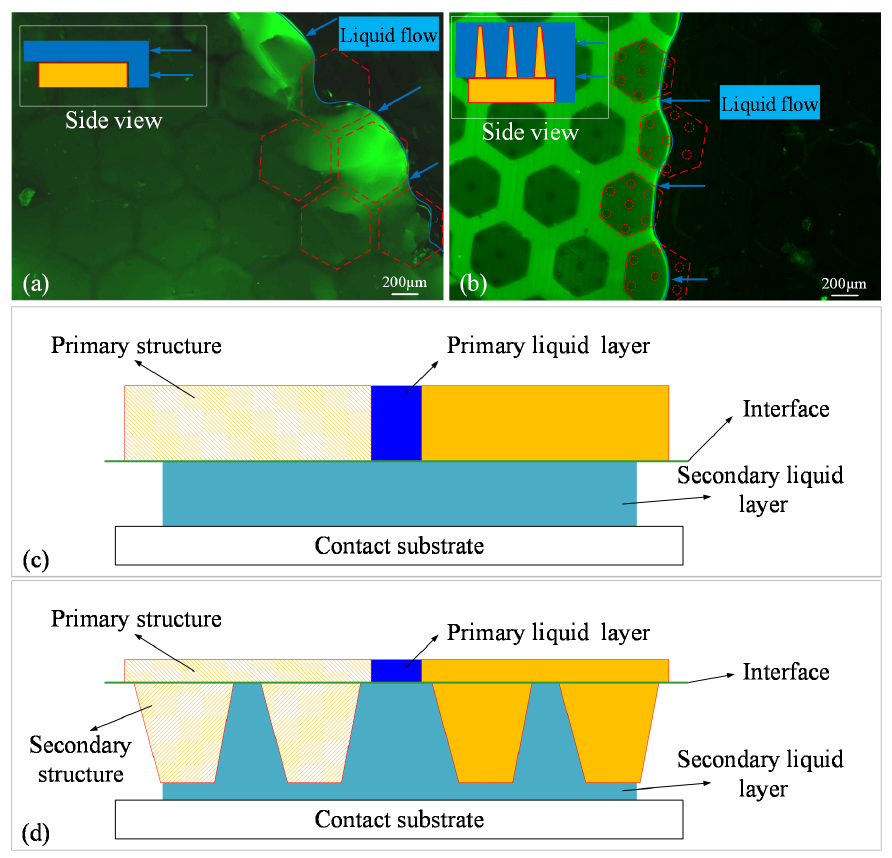
Figure 10. Variation in the contact interface when different lip ring microstructures are peeled from the substrate. A thin liquid film exists between ( a ) the single-level and ( b ) the large-scale hierarchical micropatterned surface and the substrate, respectively; ( c ) Cross-sectional profile of the single-level specimen with different liquid layers; ( d ) Cross-sectional profile of the hierarchical specimen with different liquid layers.